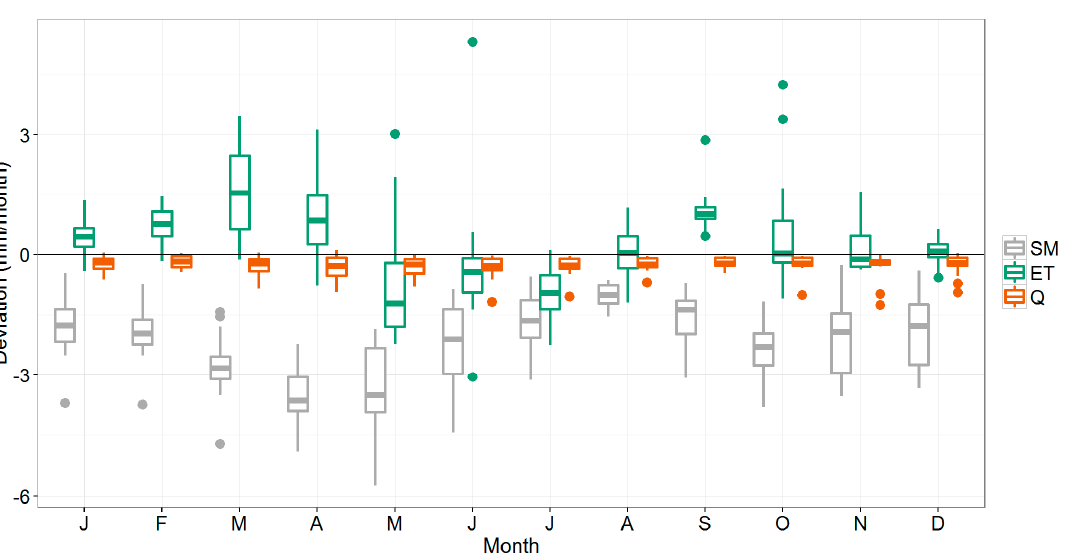
Figure 5. Boxplots showing the deviation (mm/month) of the 3_FAOseas method compared to the reference model for soil moisture (SM), actual evapotranspiration (ET), and streamflow (Q) at basin-scale. The boxes demonstrate the interquartile range in which the median is indicated as a line; the fences indicate the values that are within 1.5 times de interquartile range, and the dots the values outside of this range (“outliers”).